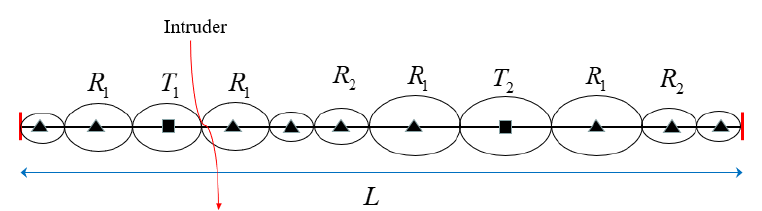
Figure 3. Heterogeneous BR barrier P with length L to detecting intruders (Squares denote transmitters and triangles denote receivers. T 1 and T 2 represent two different types of transmitters, and all receivers have the same type.).